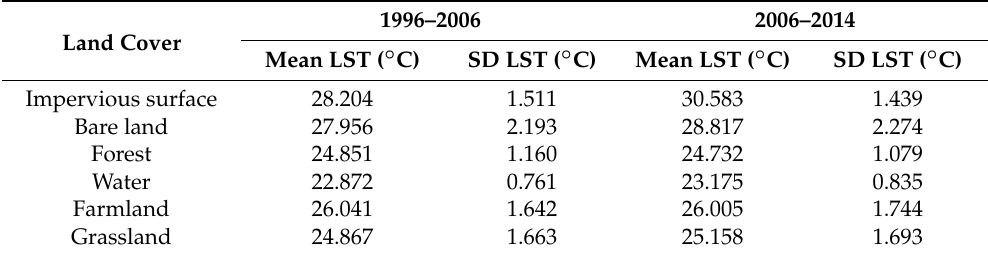
Table 4. The LST change in land cover from 1996 to 2014 (unit: ◦ C).